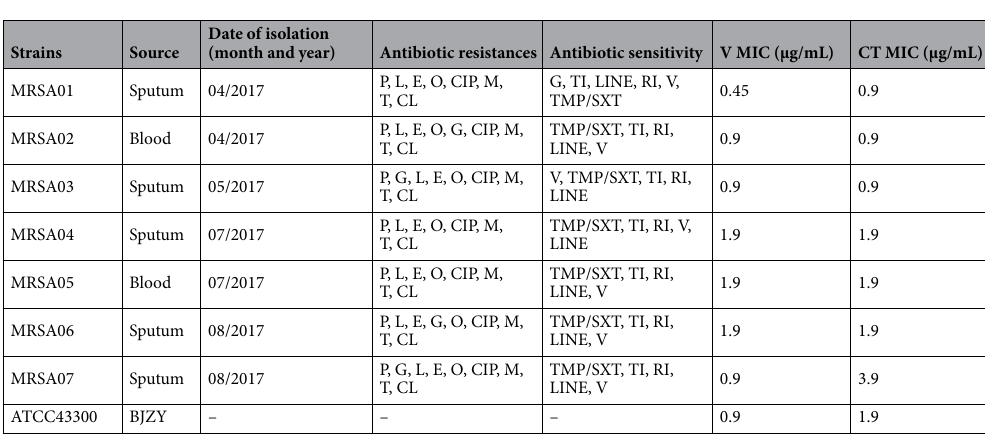
Table 1. Specimen and tests information on MRSA strains. P penicillin, L levofloxacin, E erythromycin, O oxacillin, CIP ciprofloxacin, M moxifloxacin, T tetracycline, CI clindamycin, G gentamicin, TI tetracycline, LINE linezolid, RI rifampin, V vancomycin, TMP/SXT trimethoprim–sulfamethoxazole, BJZY Beijing Zhongyuan Company, V MIC MIC of vancomycin to MRSA, CT MIC MIC of CT to